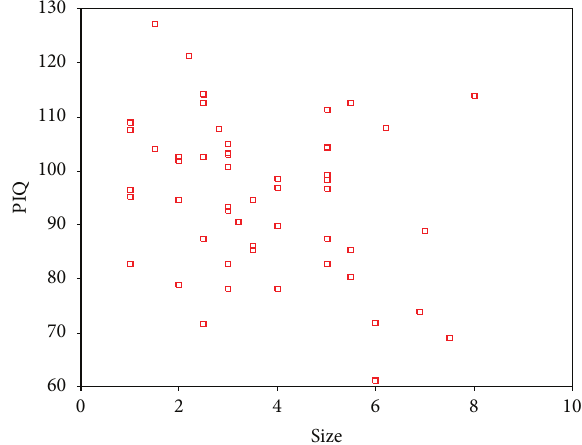
Figure 9: Partial correlation analysis showed negative relation between tumor size and PIQ in the intracerebral tumor subgroup. Correlation coefficient was − 0.432 ( 𝑃 = .002 ).